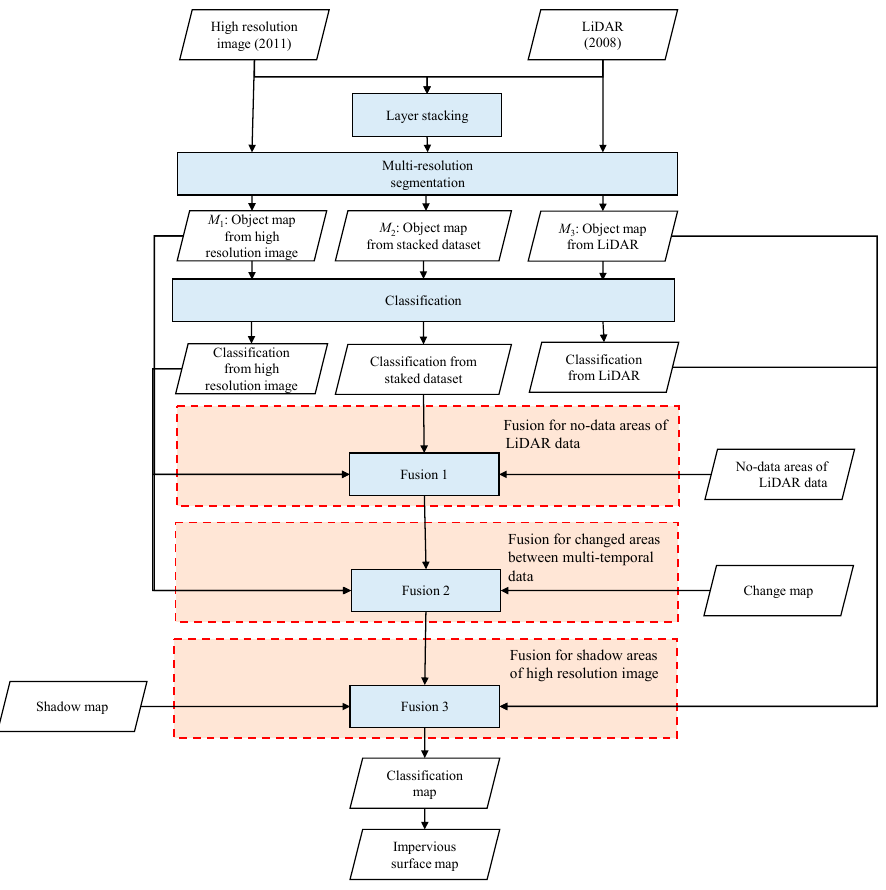
Figure 6. Flowchart of object-based post-classification fusion of multi-temporal LiDAR data and the high-resolution image. The joint classification and independent classification results are obtained at first. Then, three steps of object-based post-classification fusion is achieved to obtain the accurate classification map. The impervious surface map is obtained by merging the